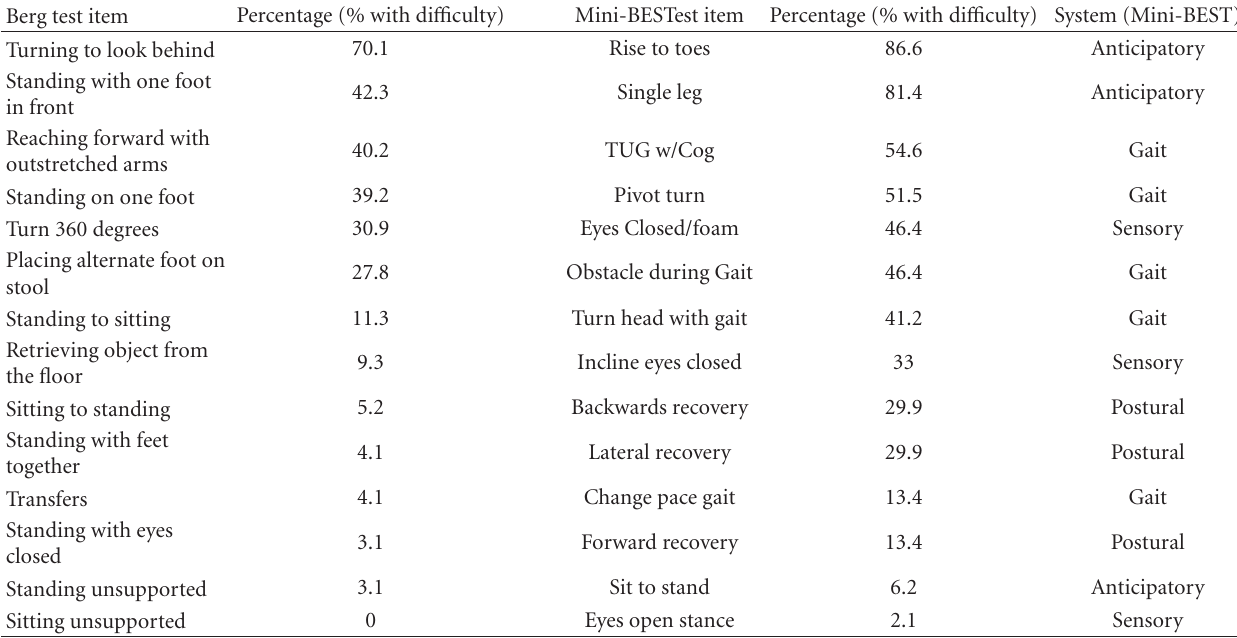
Table 2: The Berg and Mini-BESTest individual items ranked from most di ffi cult to least based on the % of participants with PD who did not have normal scores. Di ffi culty with the test was determined if the participant did not receive a perfect score. Berg test